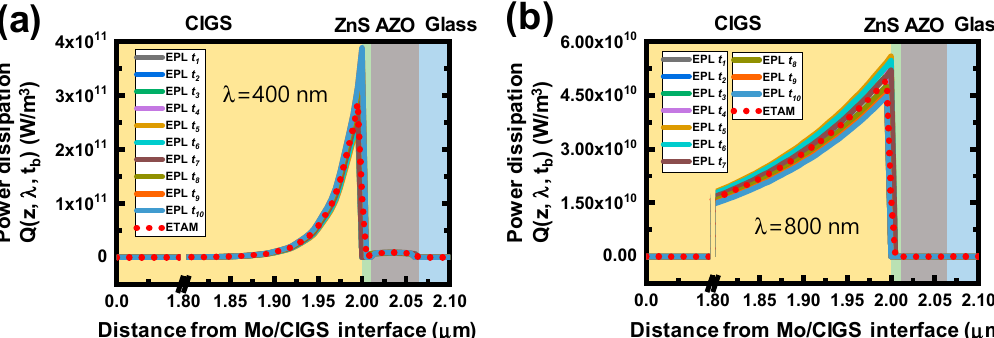
Figure 4. Calculated spatial profiles of the optical power dissipations in the longitudinal z-direction Q ( z , λ , t b ) with respect to 10 di ff erent equispaced phase thicknesses of t 1 , t 2 , ··· and t 10 . The calculation results were obtained at wavelengths of ( a ) 400 and ( b ) 800 nm. To consider the e ff ect of the incoherent cover glass, the ETAM-applied optical power dissipation Q ETAM ( z , λ ) , obtained by averaging the 10 coherent calculation results, was designated by the red dotted line.